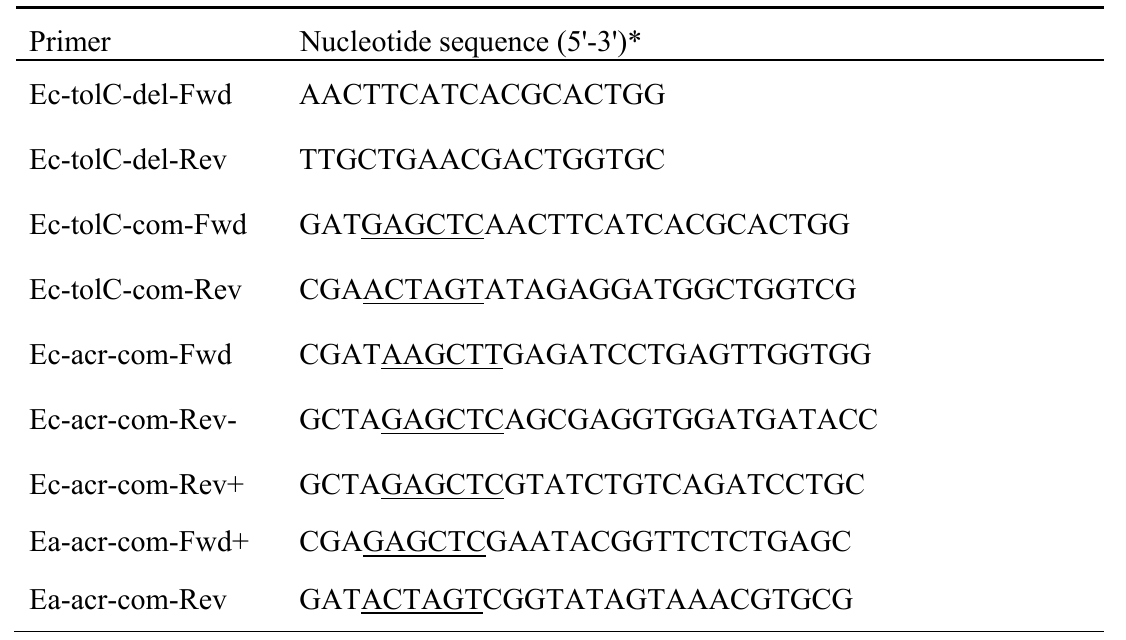
Table 7. Oligonucleotide primers used in this